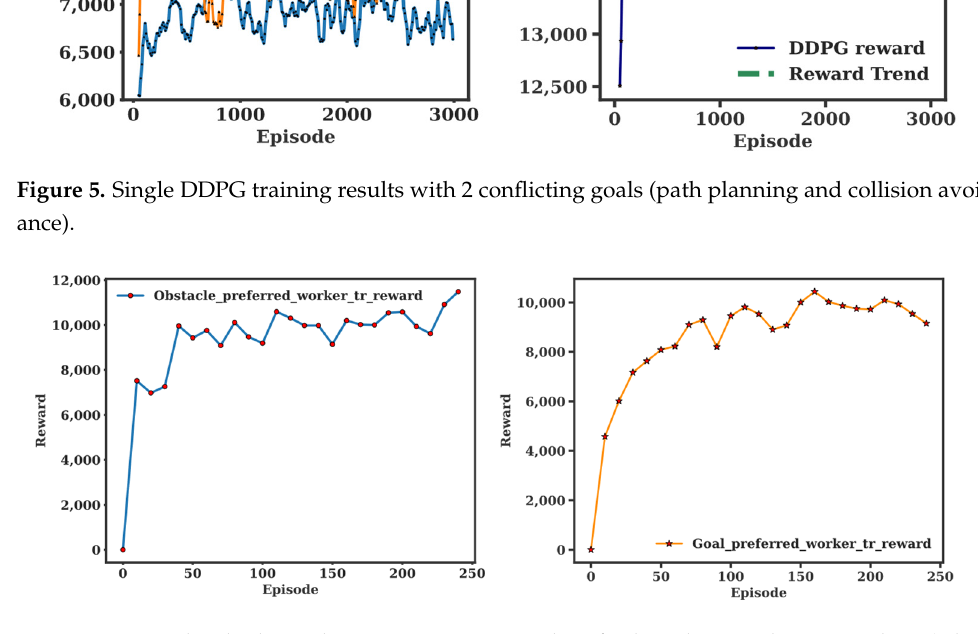
Figure 8. HDDPG demonstrated more than 35% of reward gain and more than 2 times of reward improvement rate (the slop of the linear regression). The result demonstrates that the proposed HDDPG-based hierarchical reinforcement learning architecture outperforms a general reinforcement learning algorithm, or other hierarchical learning platform, such as HAM. In summary, with a higher average reward and a steeper trend slope than the others, the HDDPG outperforms the HAM and a single DDPG, as shown in Figure 9. The average reward for HAM was 12,500, and the flat trend indicates no evidence of reward gain. The single DDPG improved its reward, with an